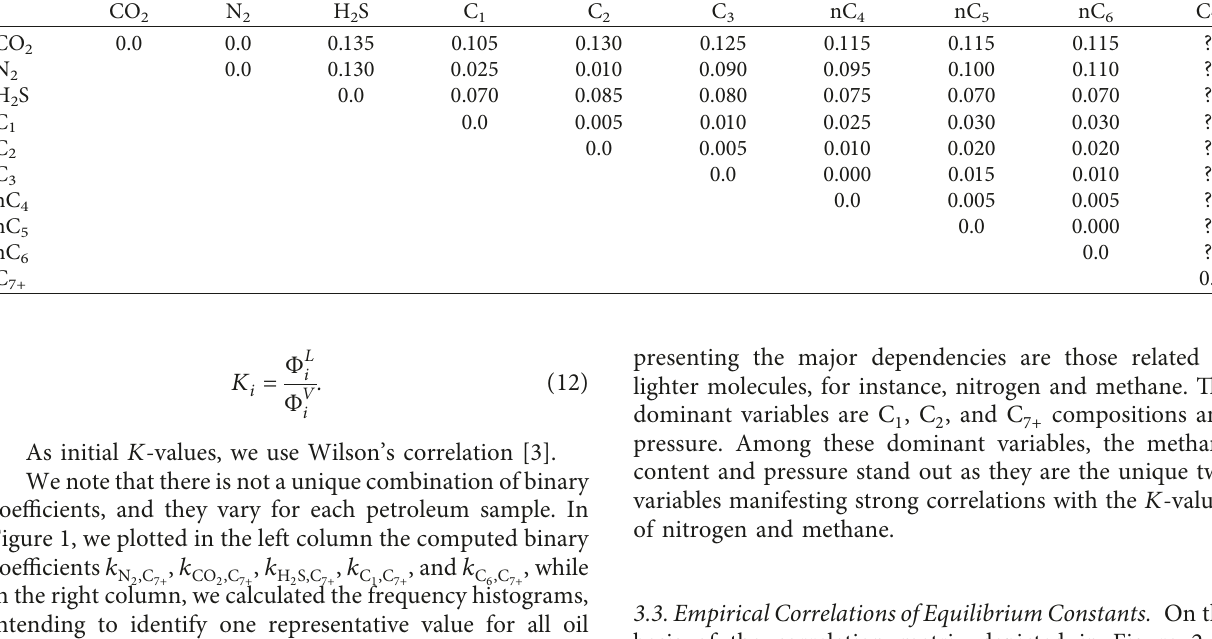
Table 1: Binary interaction coefficients k